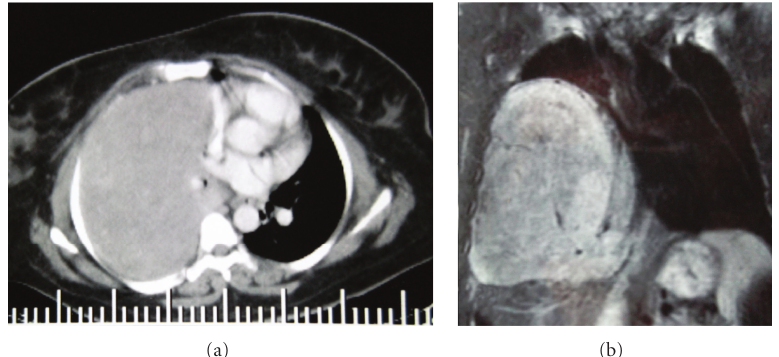
Figure 1: Giant mass can be seen that almost completely filled the right hemithorax on CT (a). Mediastinal shift was seen on MRI (b).